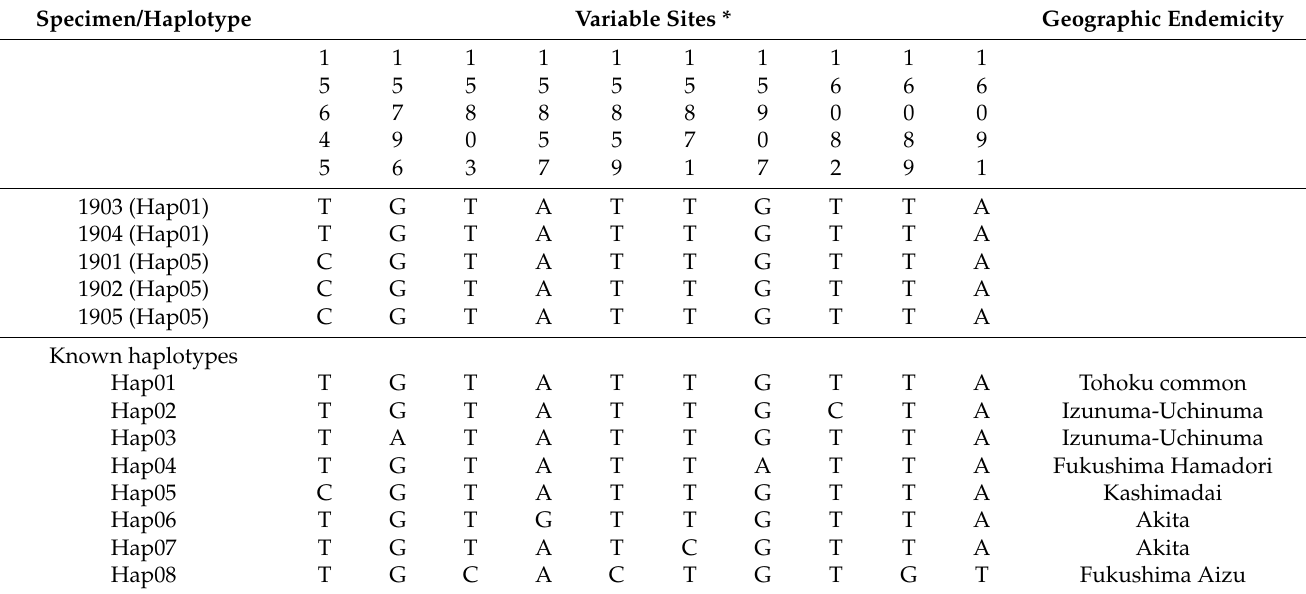
Table 1. Haplotypes of the endangered bitterling Acheilognathus typus collected from an irrigation pond in northern Niigata prefecture in comparison with known types [13]. Specimen/Haplotype Variable Sites